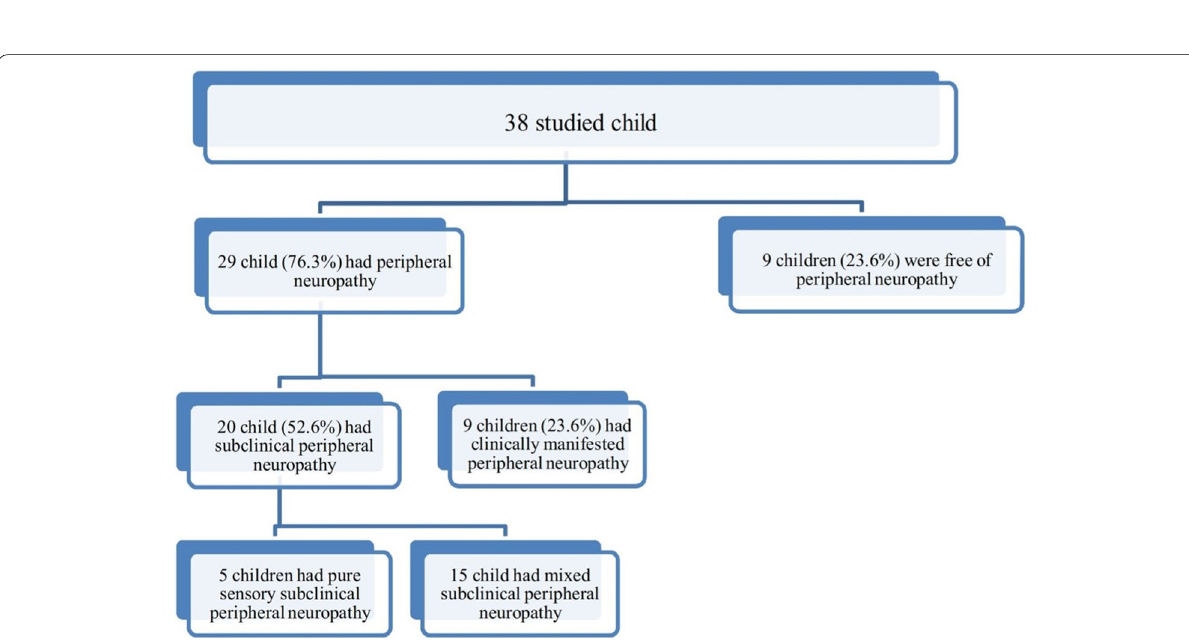
Fig. 3 Distribution of the studied children according to peripheral neuropathy ( n